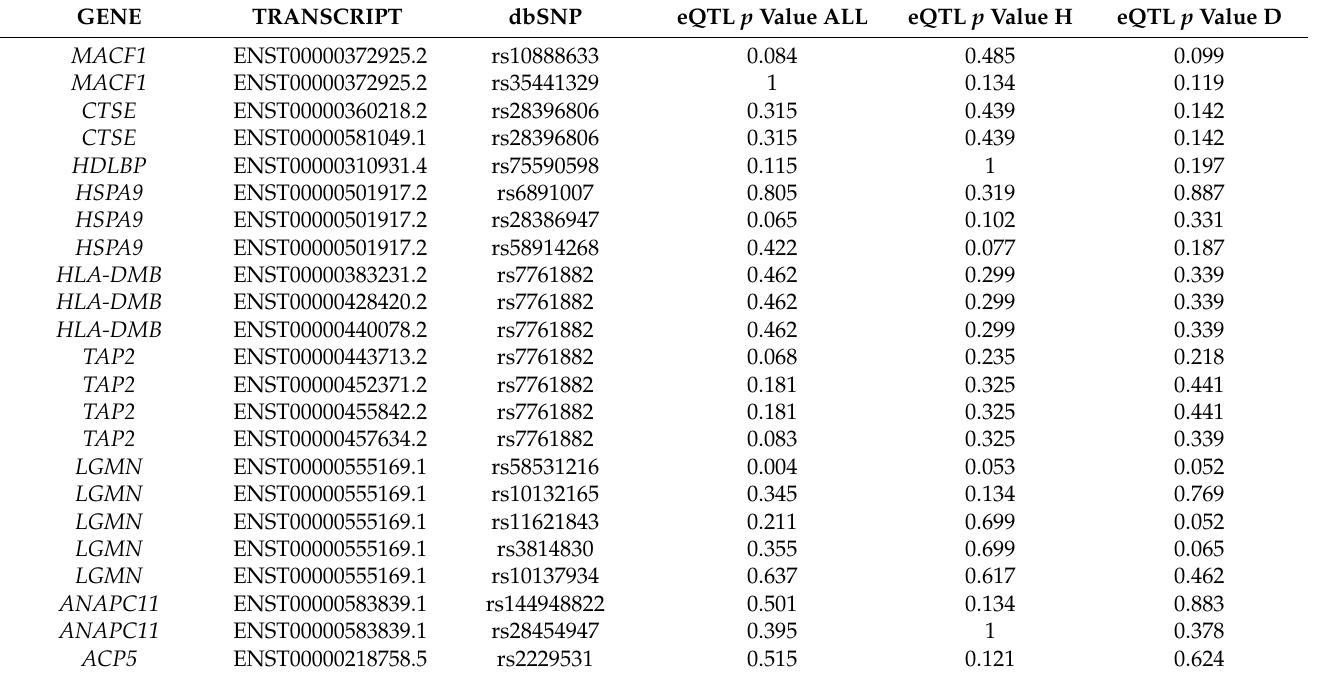
Table 3. Estimated and calculated transcript